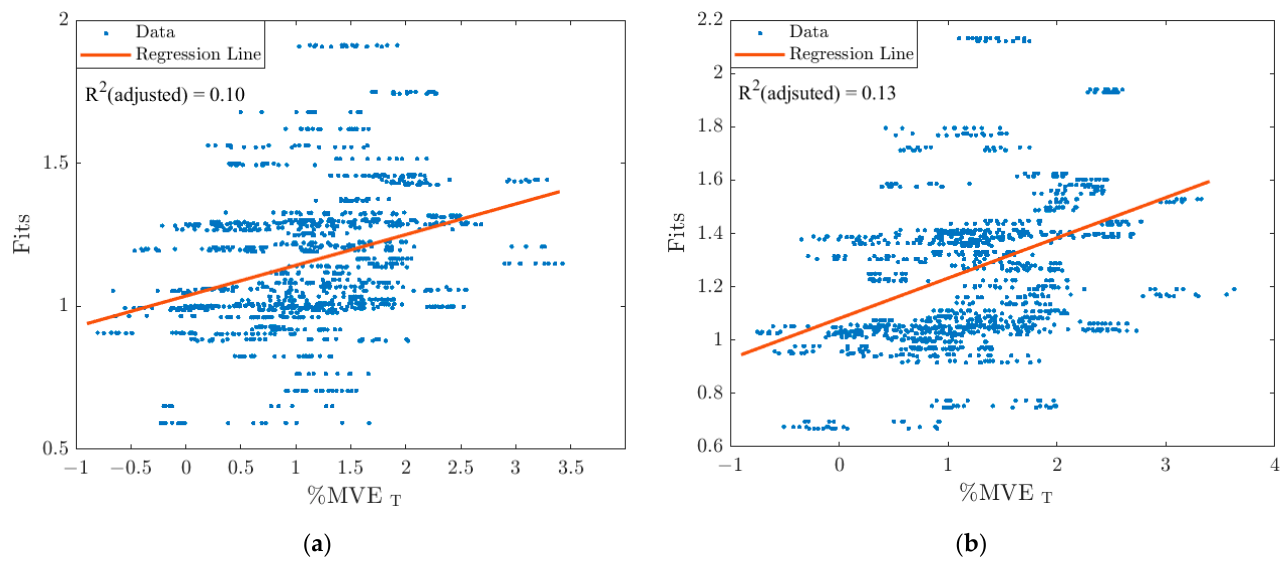
Figure 6. Fits vs. %MVE T (transformed % maximum voluntary electrical activation data) ( a ) before and ( b ) after back muscle fatigue from the stepwise regression models of the thoracic erector spinae (TE).